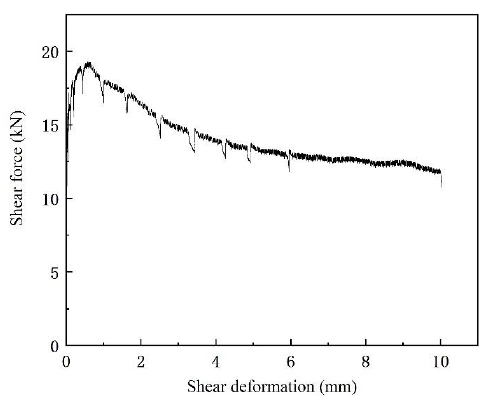
Figure 13. Load – displacement curve for the mortar shear test. Figure 13. Load–displacement curve for the mortar shear